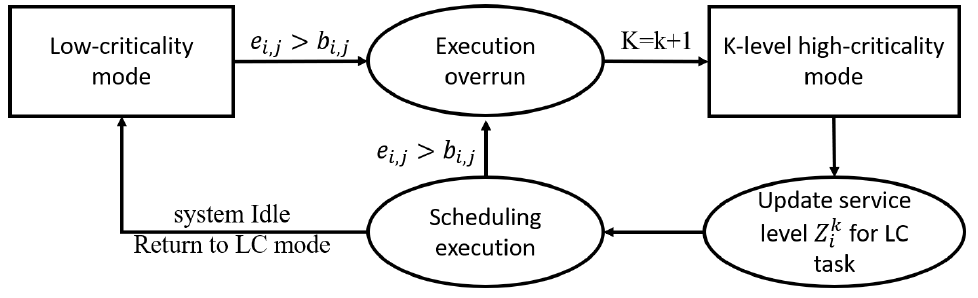
Figure 3. FDMC execution